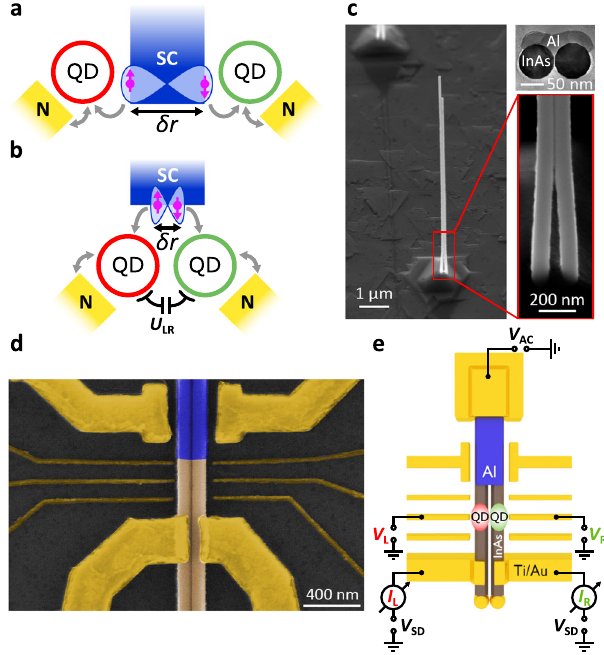
Fig. 1 Device outline. a Concept of a single-nanowire based Cooper pair splitter. Lower bound for δ r is the width of the SC with negligible cross-capacitance between the QDs. b Same as panel ( a ), but in double, parallel nanowires. While δ r can be minimized, U LR becomes signi fi cant. c High-resolution SEM micrographs of the as- grown nanowires imaged from the opposite side of the Al covering. ATEM image on the top shows the cross-section of the material with the Al connecting the two InAs wires. d False-colored scanning electron microscopy (SEM) image of the device. The epitaxial Al (blue) was etched away from half of the InAs nanowires (brown). Two separate and a shared Ti/Au contacts and side gate electrodes (yellow) were evaporated to control the transport. e Schematic illustration of the measurement setup. The left (red) and right (green) QDs were tuned by V L and V R , respectively, and were biased simultaneously by V SD . The currents in the two arms were measured via I/V converters, yielding the differential conductance G L and G R